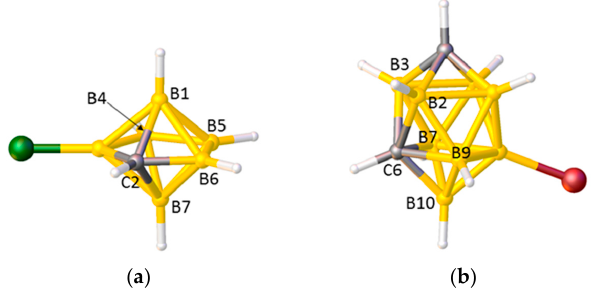
Figure 2. ( a ) The structure of [3-Cl- closo -2-CB 6 H 6 ] − . C2 − B1 1.741(3), C2 − B7 1.746(3), B4 − B5 1.665(3), B5 − B6 1.640(4) Å; ( b ) The structure of [8-Br- closo -1,6-C 2 B 8 H 9 ]. C6 − B2 1.736(5), C6 − B3 1.745(5), C6 − B7